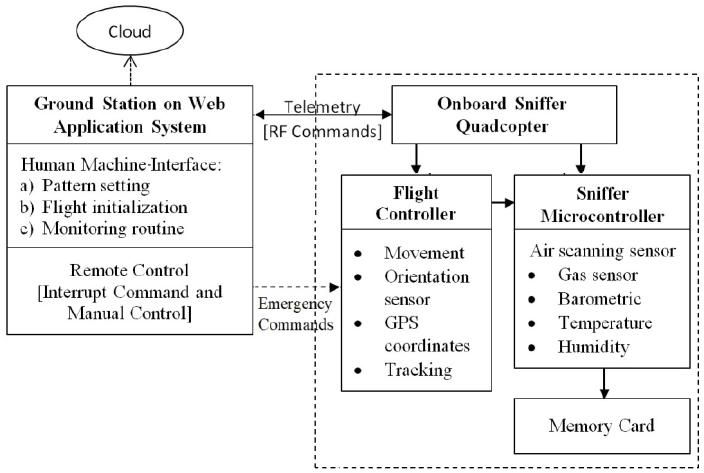
Figure 1. Sni ff er quadcopter system architecture. Sensors 2019 , 19 , x FOR PEER REVIEW